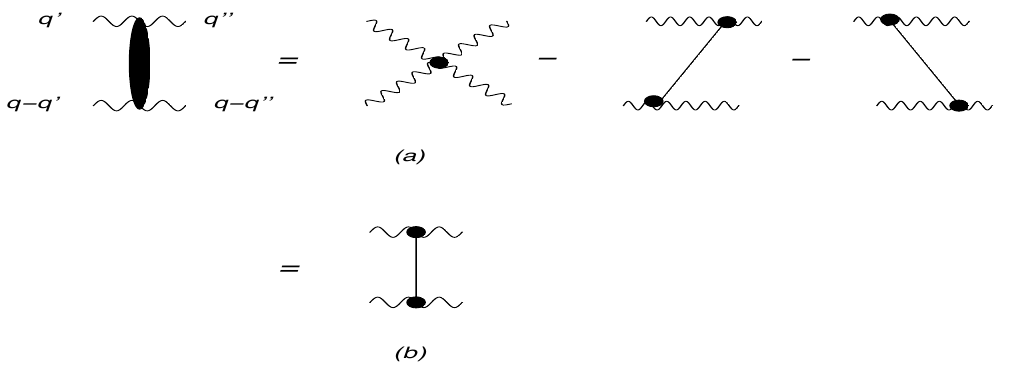
Figure 2 . Structure of the BFKL kernel with (a) real momenta and with (b) complex momenta. The dots remind of the momentum factors of the vertices which are speci(cid:12)ed in